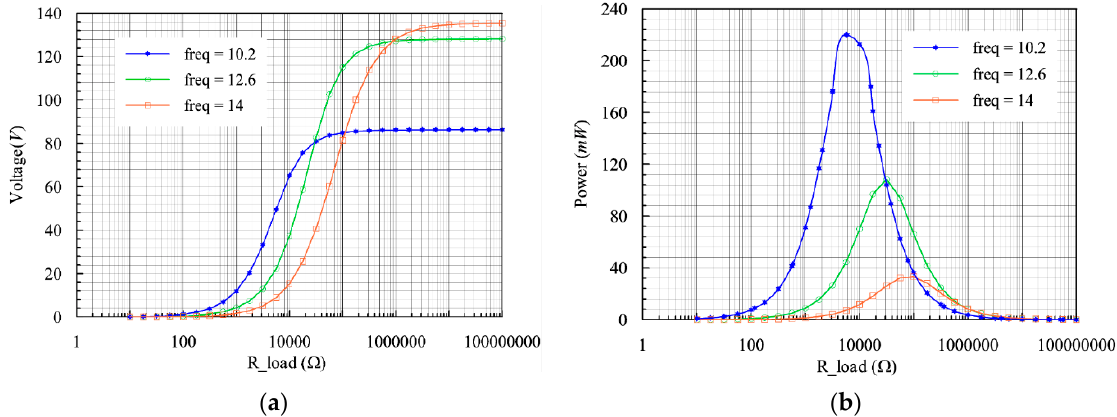
Figure 6. Response with variation in load: ( a ) voltage ( V ) and ( b ) power ( mW ).